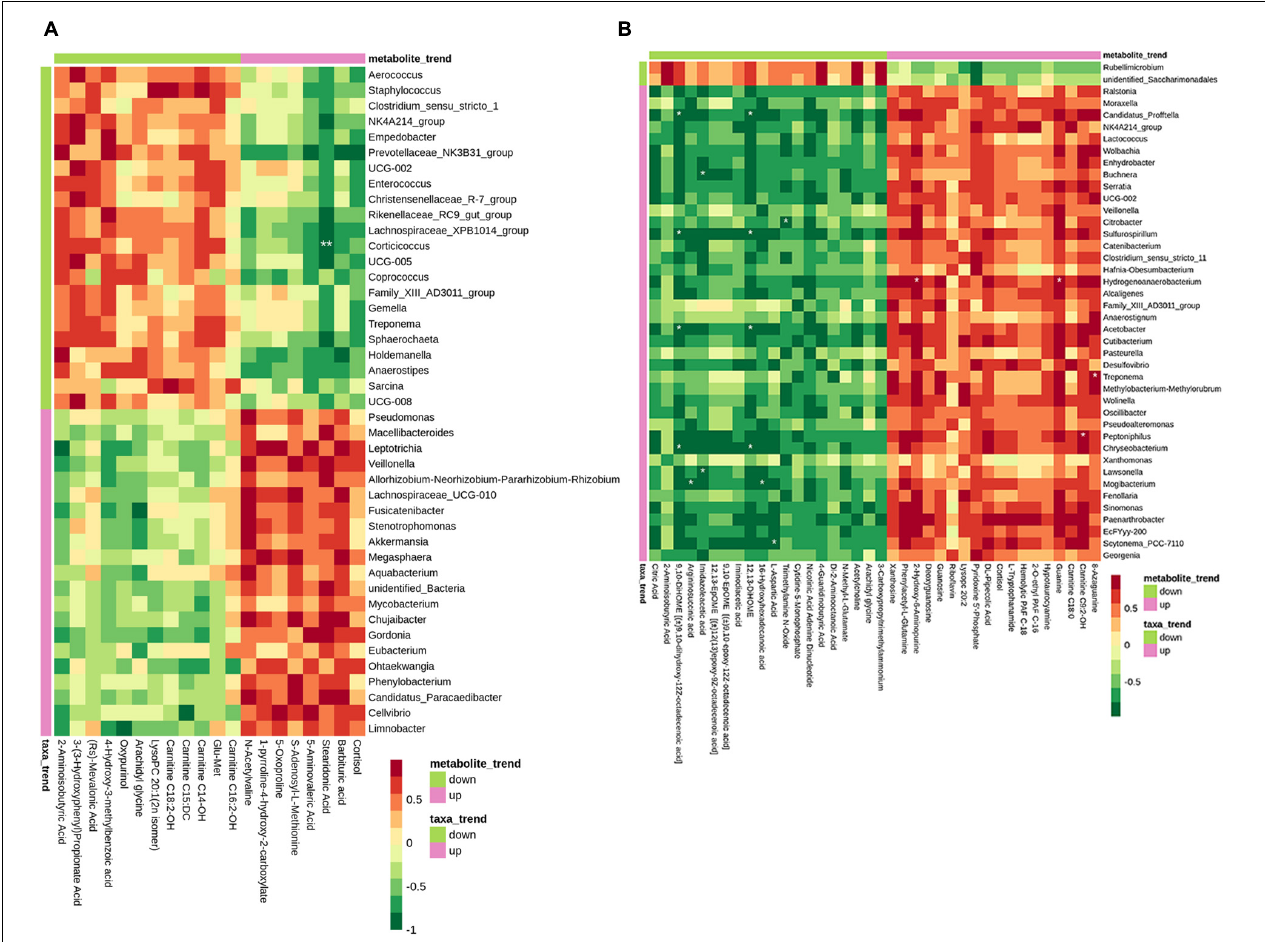
FIGURE 8 | Correlation analyses between bacterial genera and metabolites in the sow’s milk. Heat map correlation showing the associations among bacterial genera and metabolite in the colostrum (A) and transitional milk (B) . p Values for pairwise comparisons of metabolites and bacterial genera. p Values are shown as * p < 0.05, ** p <